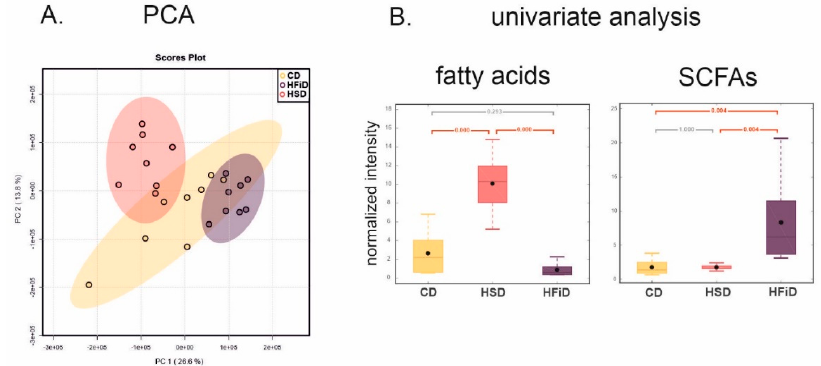
Figure 7. Diet-induced changes in the fecal metabolome. ( A ) Score plots of principal component analysis (PCA) model. ( B ) Box plots reflecting levels of short-chain fatty acids (SCFAs) and fatty acids. p -Values in box plots were calculated by parametric ANOVA. CD, control diet; HSD, diet rich in simple carbohydrates; HFiD, diet rich in fiber.